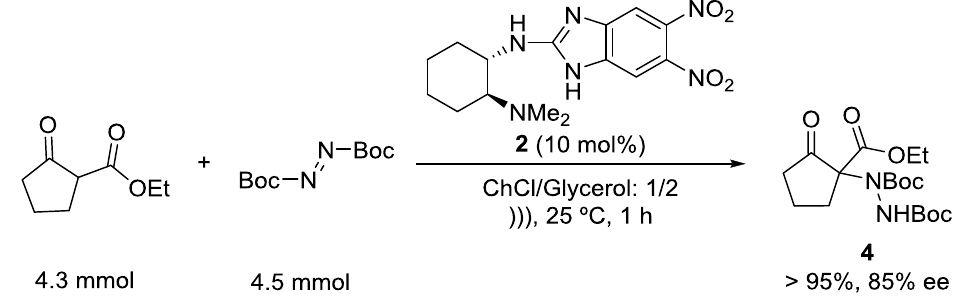
Table 3. Asymmetric α-amination catalyzed by 3 . Reaction scope.